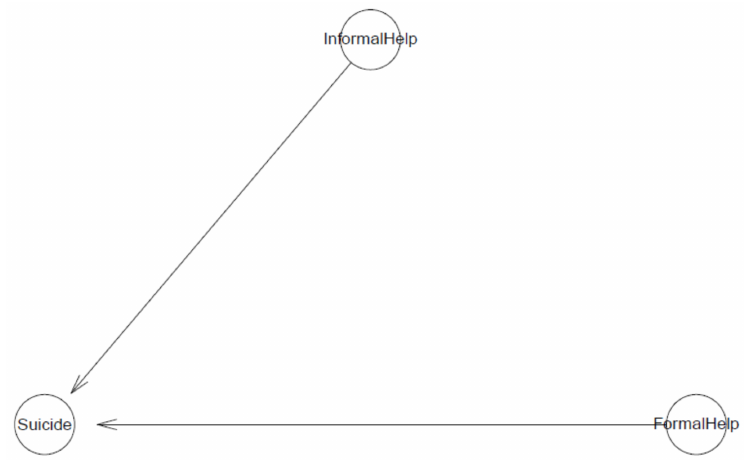
Figure 15. Model 4 (cid:48) s logical